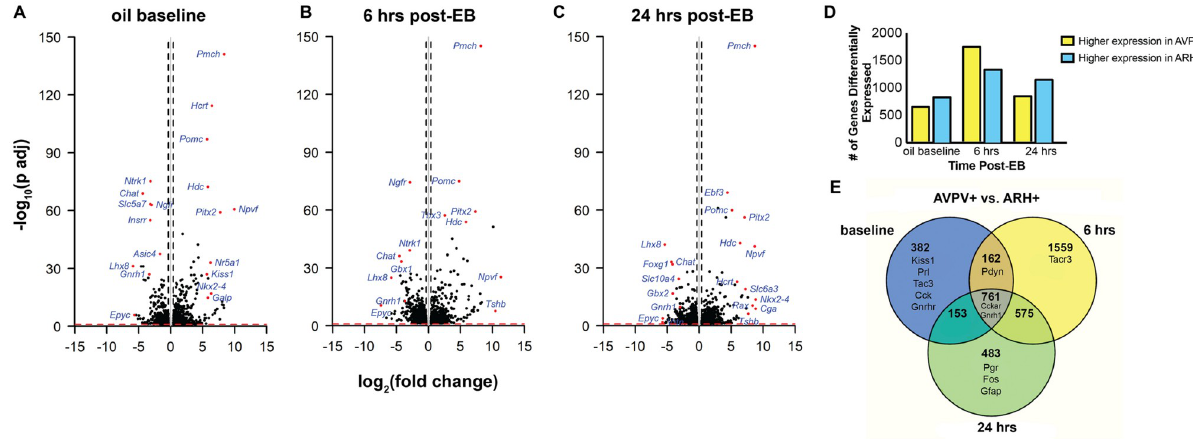
Fig 2. Differential gene expression analysis comparing gene expression levels in the AVPV+ compared with the ARH+ at oil baseline, 6 hrs, and 24 hrs post-EB. (A-C) Volcano Plots illustrating fold-change (log base 2) plotted against FDR-adjusted p value (- log base 10) of genes differentially expressed between brain regions at each time post-EB. Horizontal bar at y = 1 represents a significance level of FDR < 0.1, p < 0.01, and vertical lines indicate fold change > = |1.3| (dots below and between these lines did not reach our threshold of significance). (D) Bar graph depicting the numbers of genes with significant differential expression between the AVPV+ and ARH+ at different times post-EB treatment. (E) Venn diagram presents the overlap of 874 genes that are differentially expressed at each time point post-EB comparing expression in the AVPV+ to the expression in the ARH+.